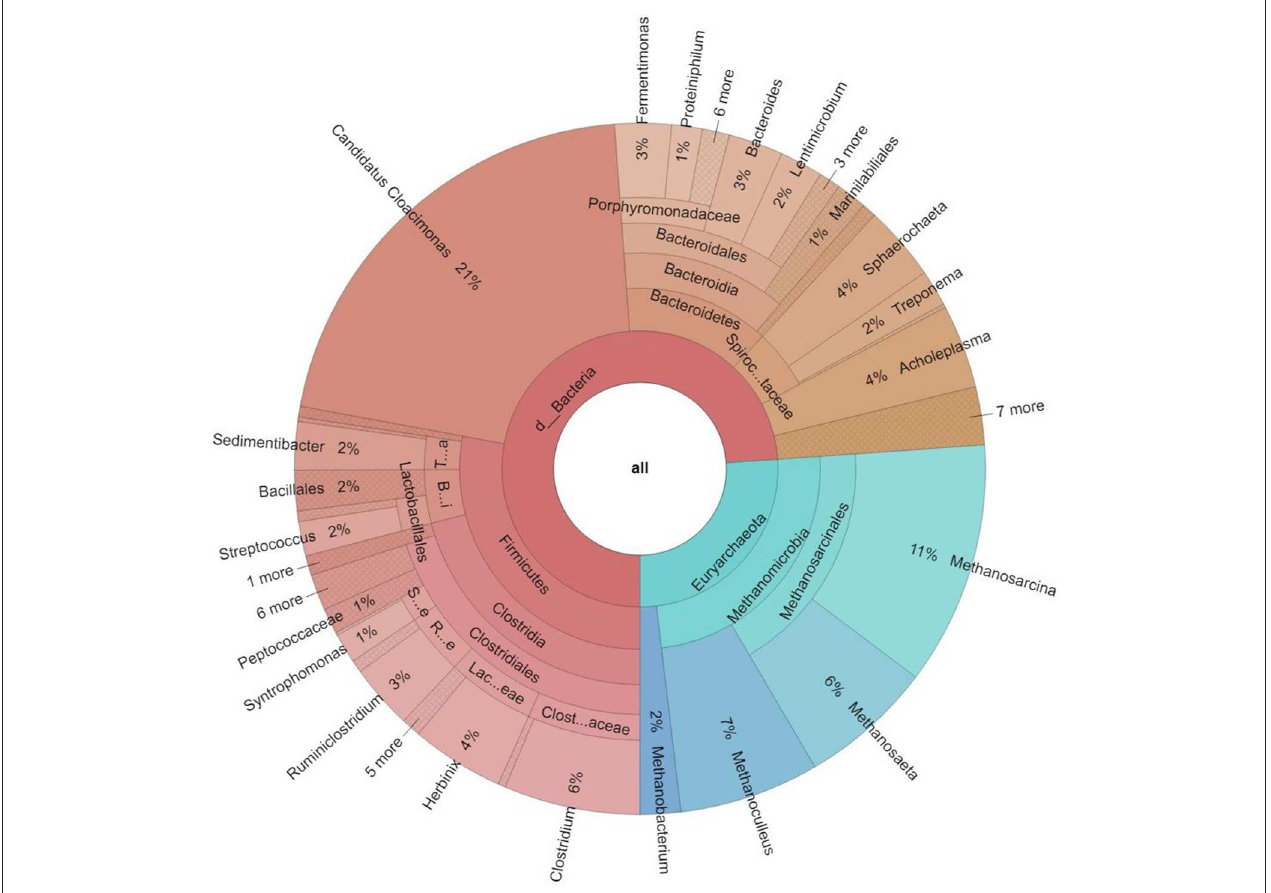
FIGURE 3 | Taxonomic distribution of the core microbiome, i.e., the taxa present in all 16 metagenomes at domain, phylum, class, order, family and genus levels. The % abundances indicate the mean averages of all samples investigated. Only the genera present in ≥ 1% abundance are listed on the outermost circle. In the domain Bacteria the genera Candidatus Cloacimonas and Clostridium prevailed, among Archaea Methanosarcin a, Methanoculleus, and Methanosaeta predominated.